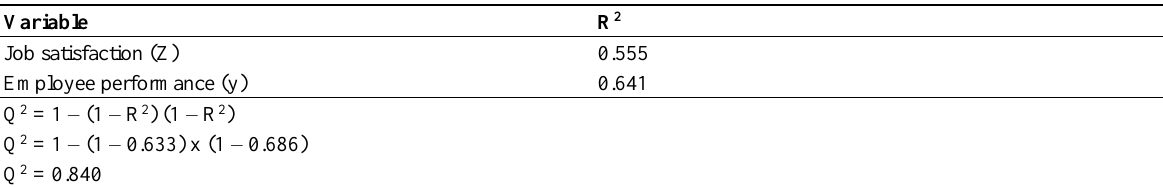
Table 6: Goodness of Fit Model